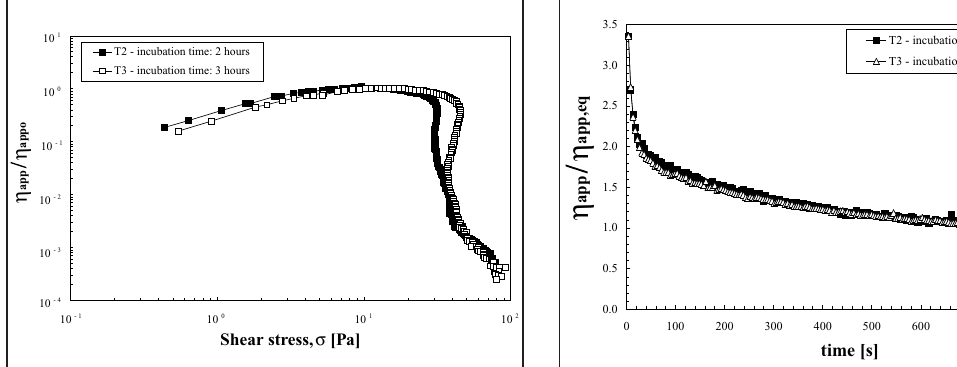
Figure 2 (left): Representative plot of reduced apparent viscosity ( η APP / η APP0 ) versus shear stress (upward cycle) of set-style yoghurt with different incubation times (T2 and T3 yoghurt samples). Figure 3 (right): Representative plots of structure degradation in time (T2 and T3 yoghurt samples).